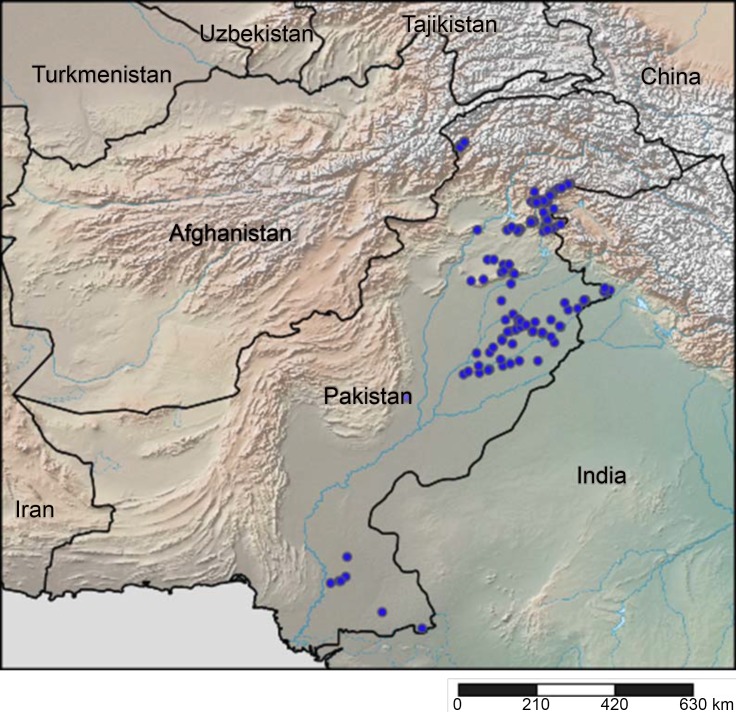
Collection sites for thrips in Pakistan.The map was generated by www.simplemappr.net using GPS coordinates.